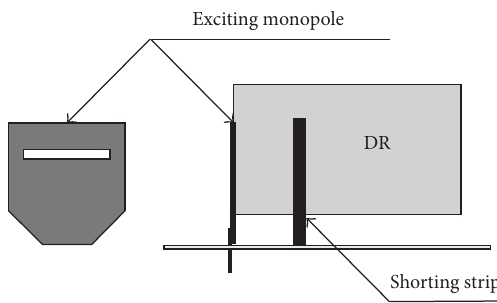
Figure 57: Geometry of a UWB rectangular DRA with a bandstop [67]. Dark gray metal and medium gray